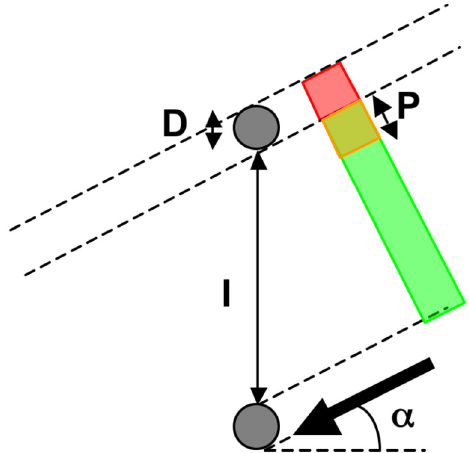
Figure A4. Geometric analysis for the round bar armour system.